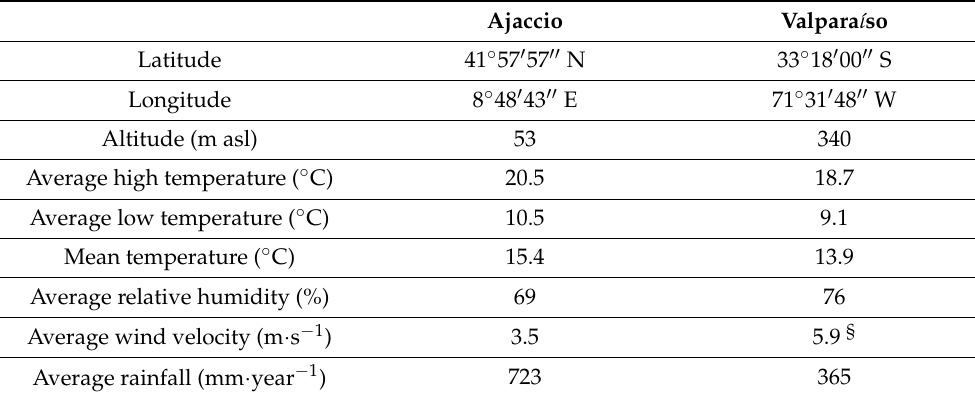
Table 1. Meteorological specific information for both test locations. ( § ): The wind speed is higher than measured at the measurement site because the meteo station is located at the top of a hill (Aer ó dromo Rodelillo, Viña del Mar).